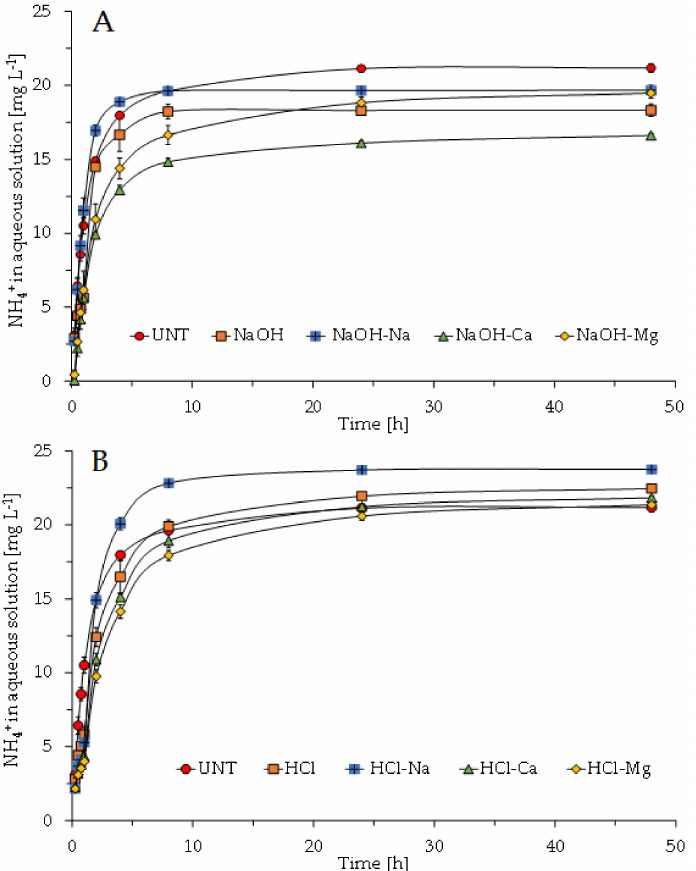
Figure 14. Ammonium adsorption kinetics by treated clinoptilolite during 48 h. Treatments are untreated clinoptilolite (UNT), pre-treated clinoptilolite with 1 M sodium hydroxide (NaOH) or 0.1 M hydrochloric acid (HCl) and treated clinoptilolite with sodium chloride (NaCl), calcium chloride (CaCl 2 ) magnesium chloride (MgCl 2 ) after NaOH ( A ) or HCl ( B ) pre-treatment. Values are mean of three replicates, and bars are standard